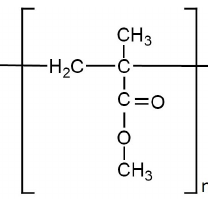
Figure 2. Molecular structure of polymethyl methacrylate. It is a hydrocarbon chain with CH ₃ and COOCH ₃ groups at the sides.